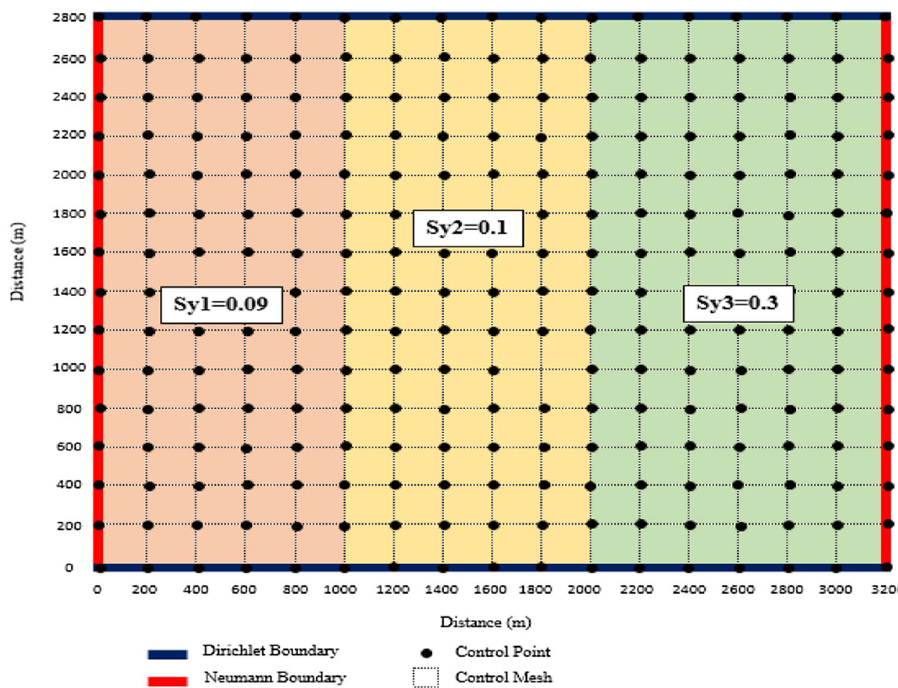
Fig. 3 Schematic view of the hypothetical aquifer under injec- tion test with different specific yield (scenario 2)